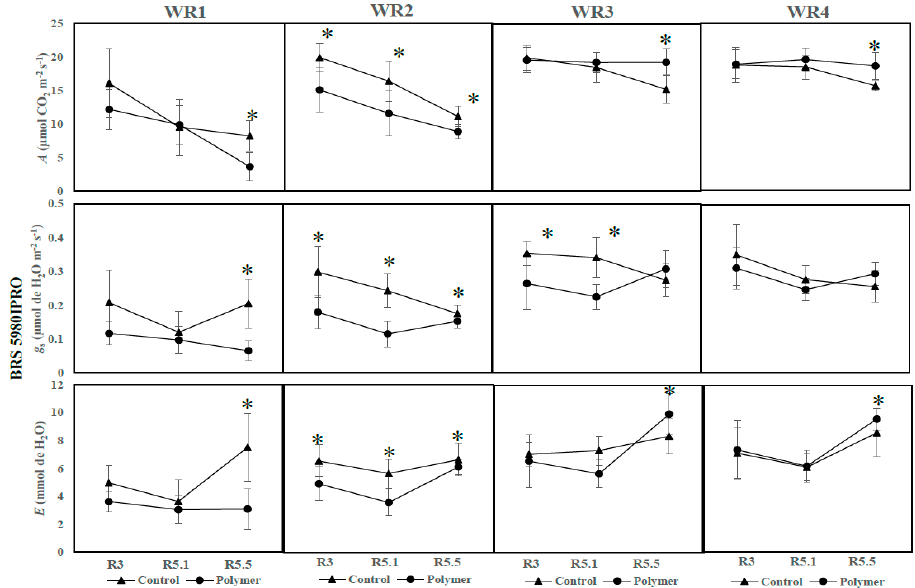
Figure 4. Photosynthesis, ( A ), stomatal conductance ( g s ) and transpiration ( E ) under four water regimes (WR) in three phenological stages of soybean with and without polymer supply (WR1 167 mm, WR2 237 mm, WR3 341 mm, WR4 534 mm) for the BRS 5980IPRO cultivar, in 2017. * indicates significant differences between the control and polymer treatments within each WR and phenolog- ical phase by Tukey’s test ( p < 0.05).